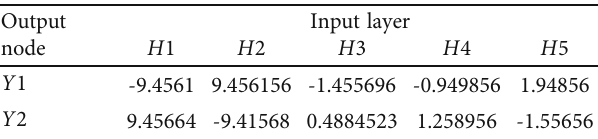
Table 2: Weights between hidden layer unit nodes and output layer unit